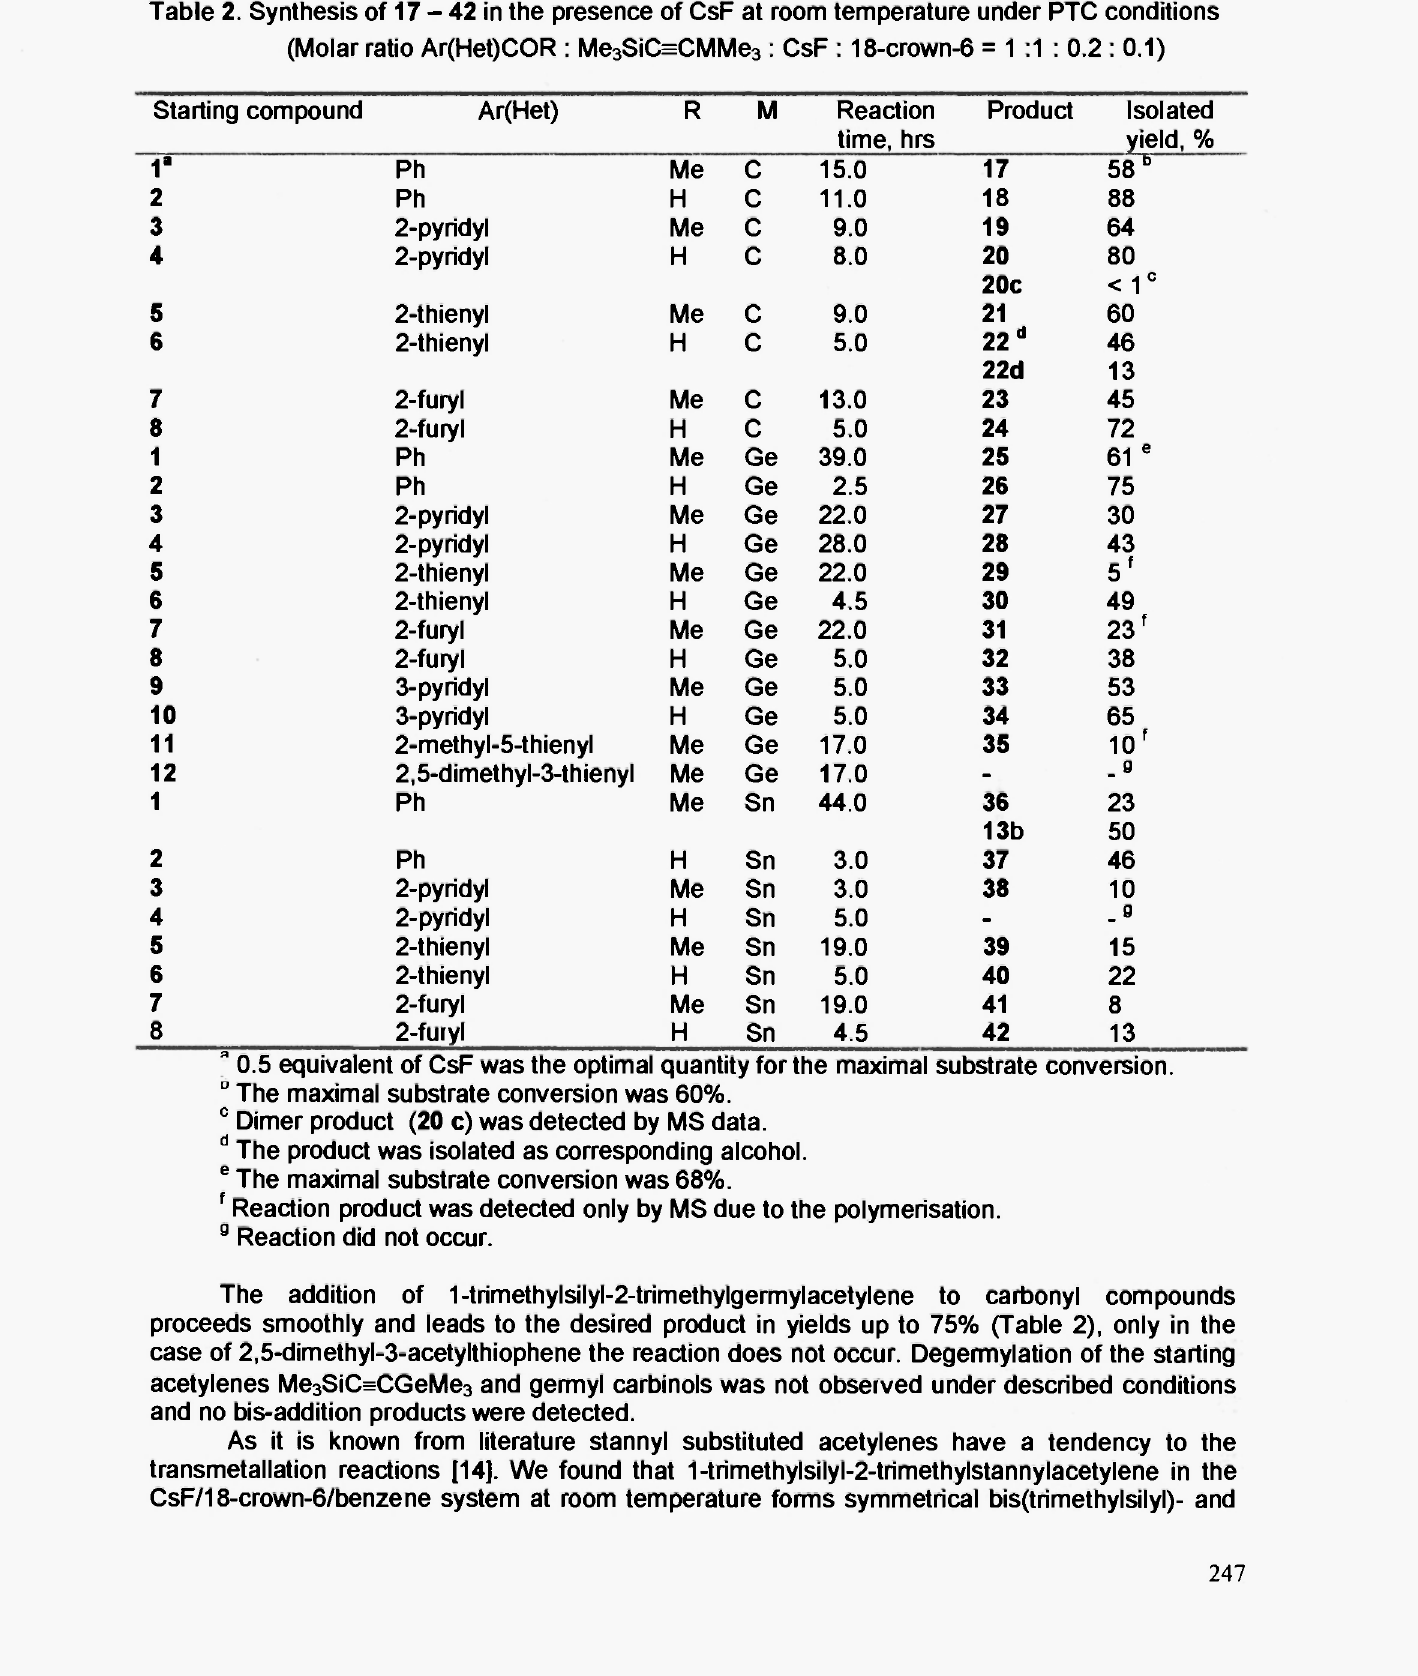
Table 2. Synthesis of 17 - 42 in the presence of CsF at room temperature under PTC